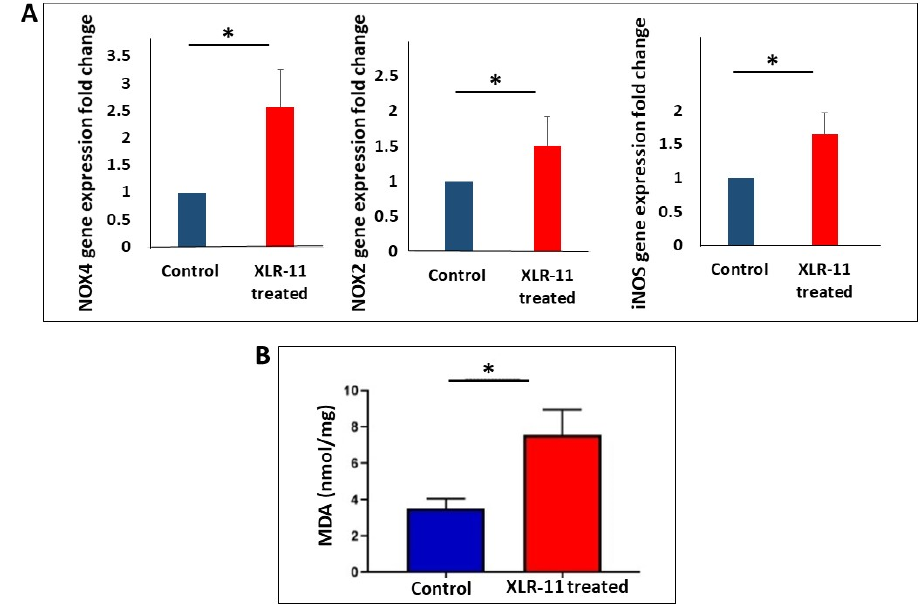
Figure 1. Gene expression of ( A ) markers of oxidative stress NOX4, NOX3, iNOS, and ( B ) MDA level in liver homogenate of control and XLR-11 treated mice, * p -value < 0.05.